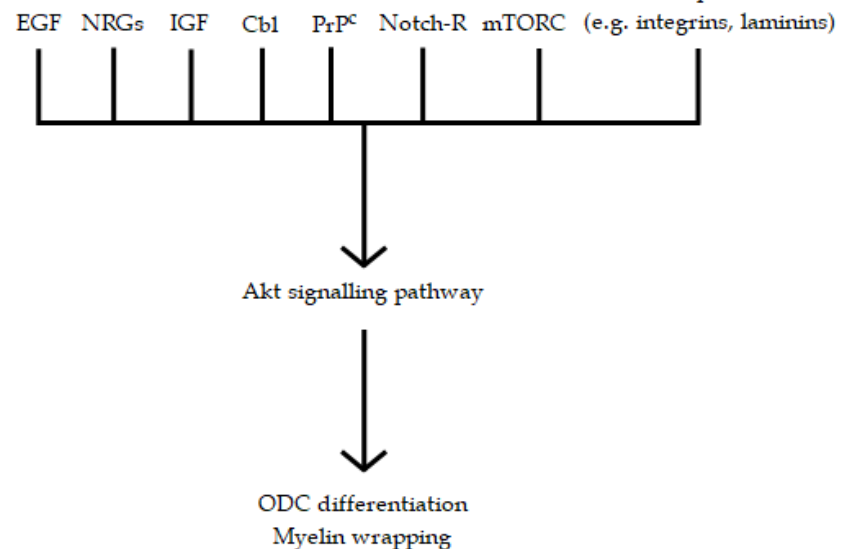
Figure 2. Various physiological molecules of the central nervous system (CNS) act through the Akt signaling pathway. The pivotal role of the Akt signaling pathway in CNS myelination is evident. See text for details and references. Cbl = cobalamin; ECM = extracellular matrix; EGF = epidermal growth factor; IGF = insulin-like growth factor; mTORC = mammalian target of rapamycin complex; NRG = neuregulin; ODC = oligodendrocyte; PrP C = normal cellular prion protein.